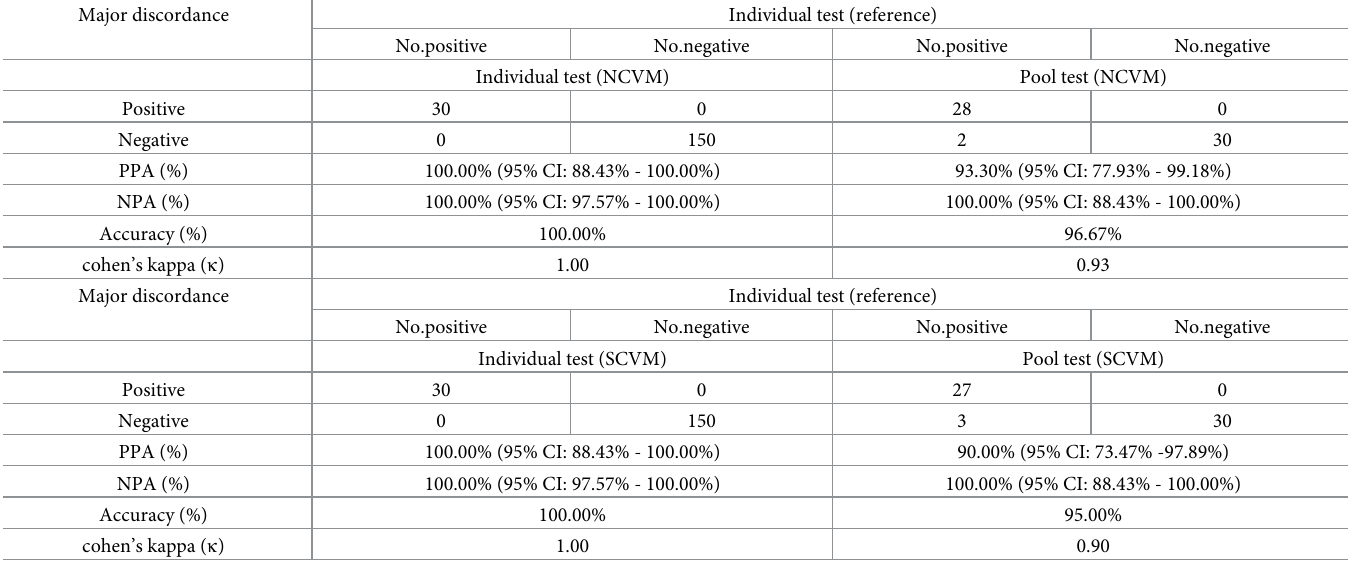
Table 6. The pooling test evaluation results for the AccuPower 1